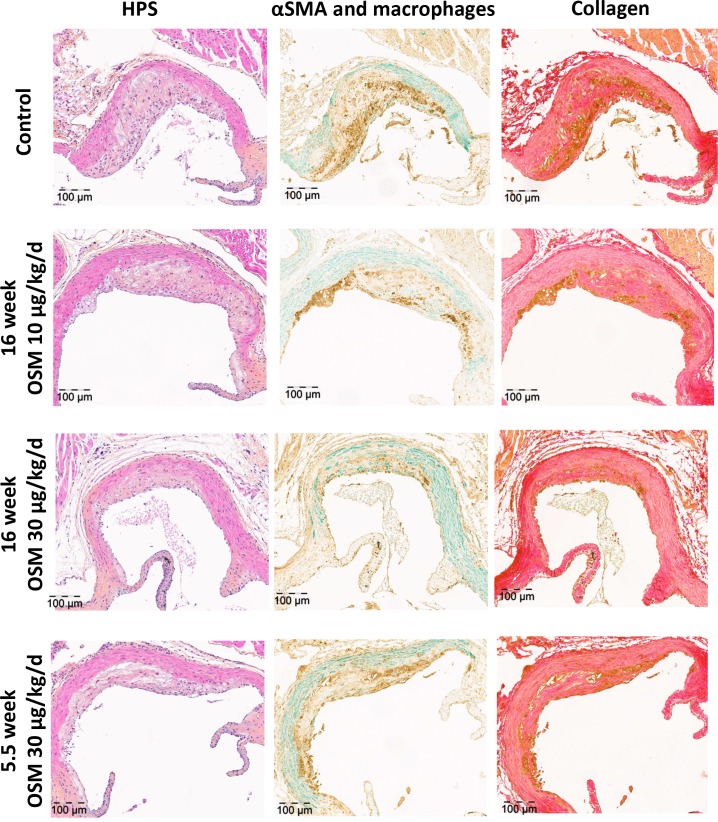
Effect of OSM on plaque composition in APOE*3Leiden.CETP mice.Representative pictures showing severe lesion types (type IV and V) stained with HPS staining, SMC staining (green), macrophage staining (brown) and collagen staining (red) to determine the effect of OSM on the lesion composition.